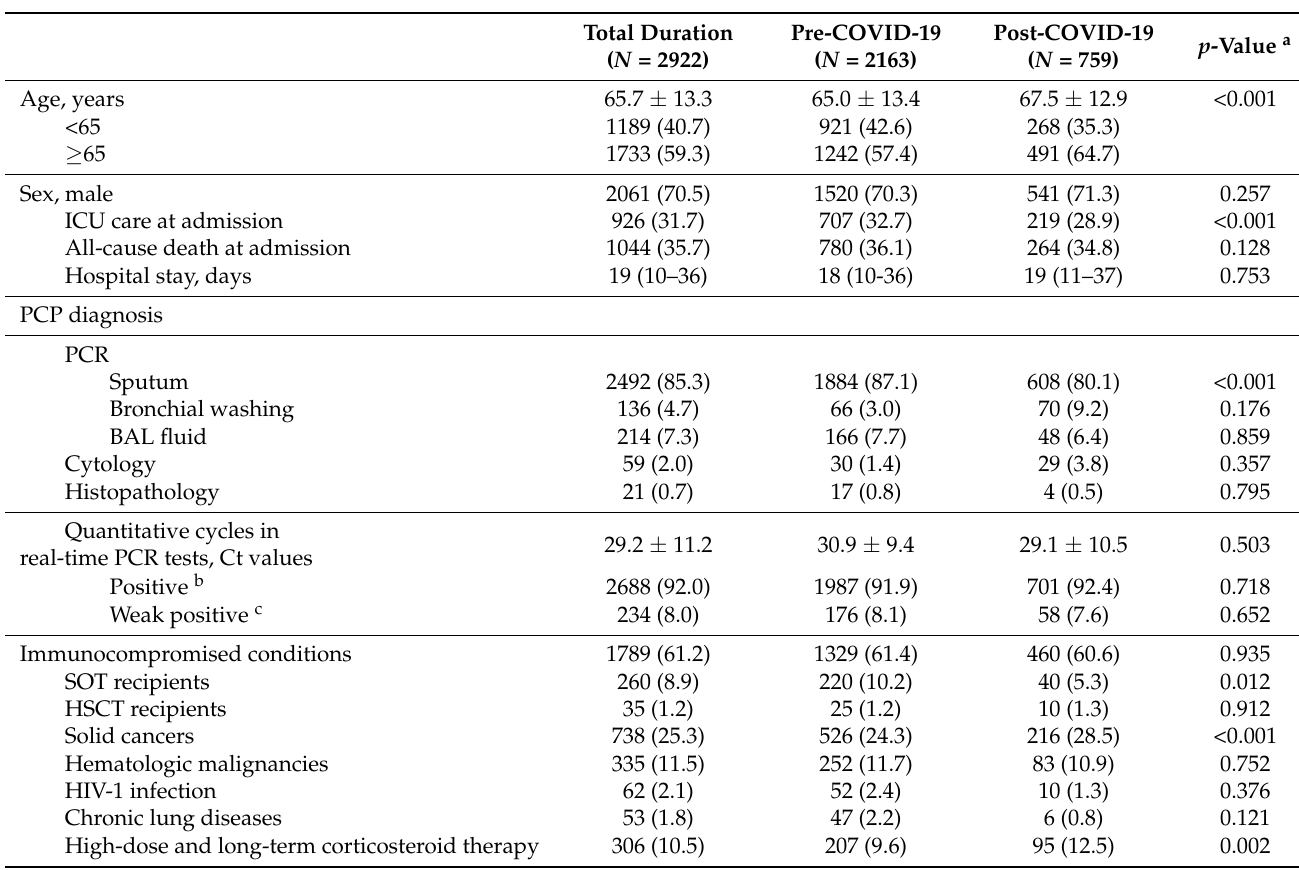
Table 1. Clinical information of PCP-confirmed inpatients between January 2015 and June 2021.